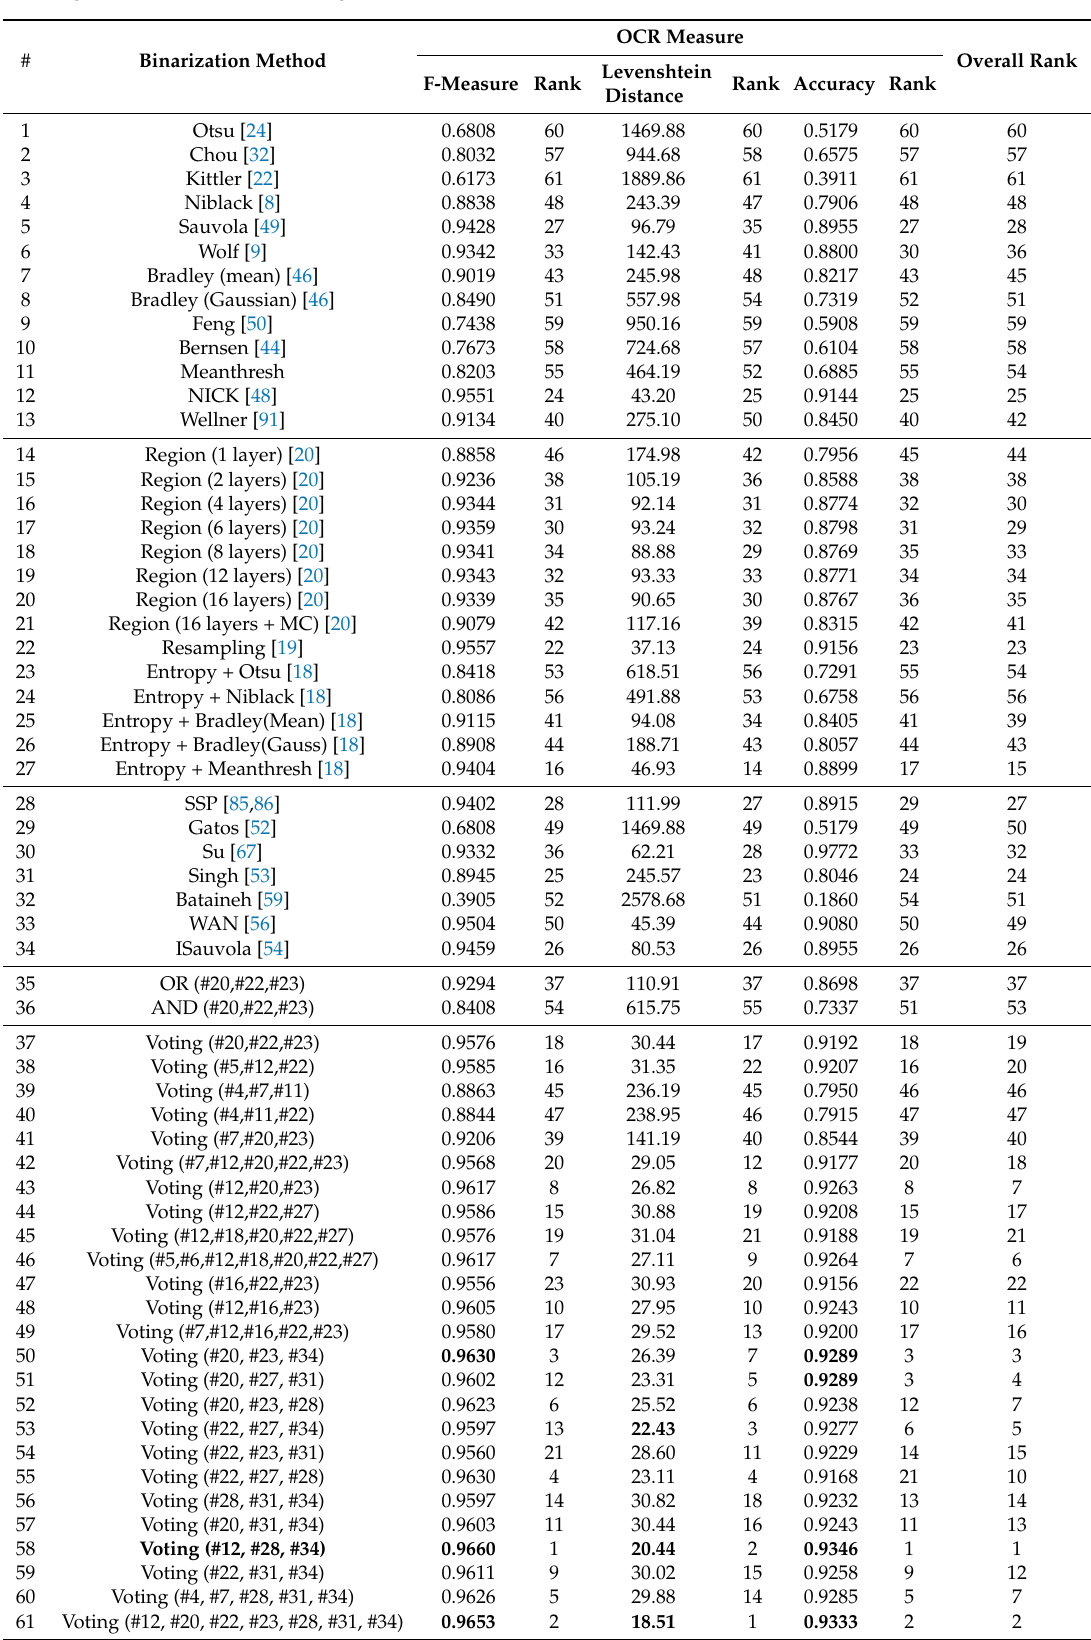
Table 1. Comparison of the average F-measure, Levenshtein distance, and Optical Character Recognition (OCR) accuracy values obtained for various binarization methods using the Tesseract OCR engine for 176 document images (three best results shown in bold